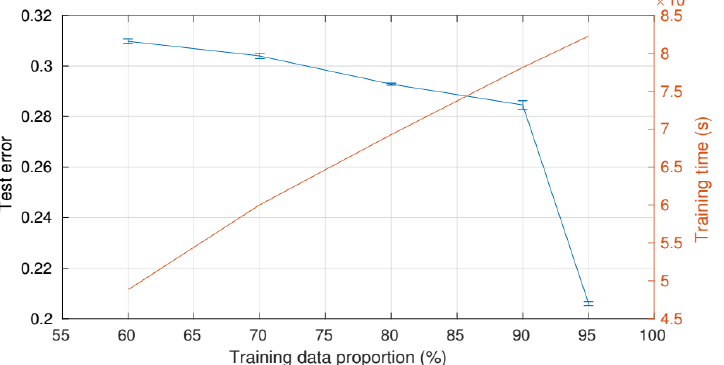
Figure 2. The relationship between the test error and error bars, training time, as well as training data proportion.